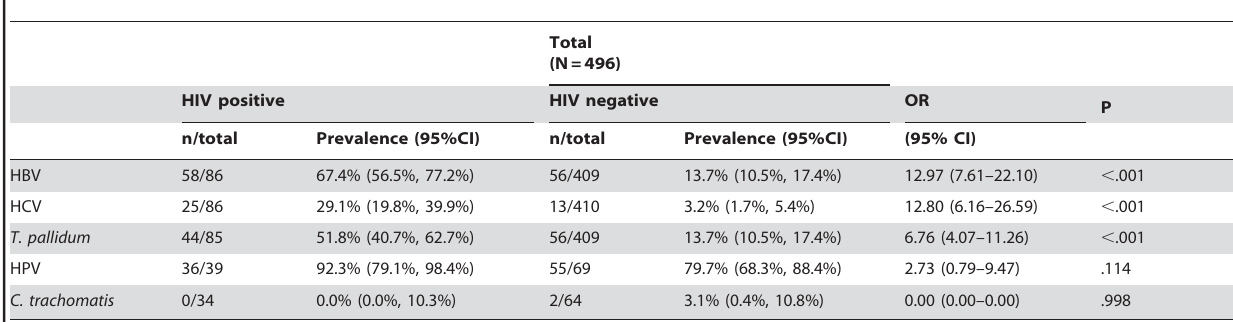
Table 3. Association between HIV and other